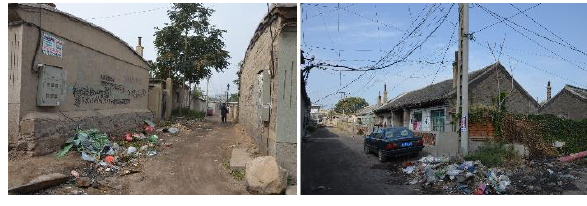
Figure 5. Public hygiene along a street in the old town of Xiongyue. Photo by Li Bing,